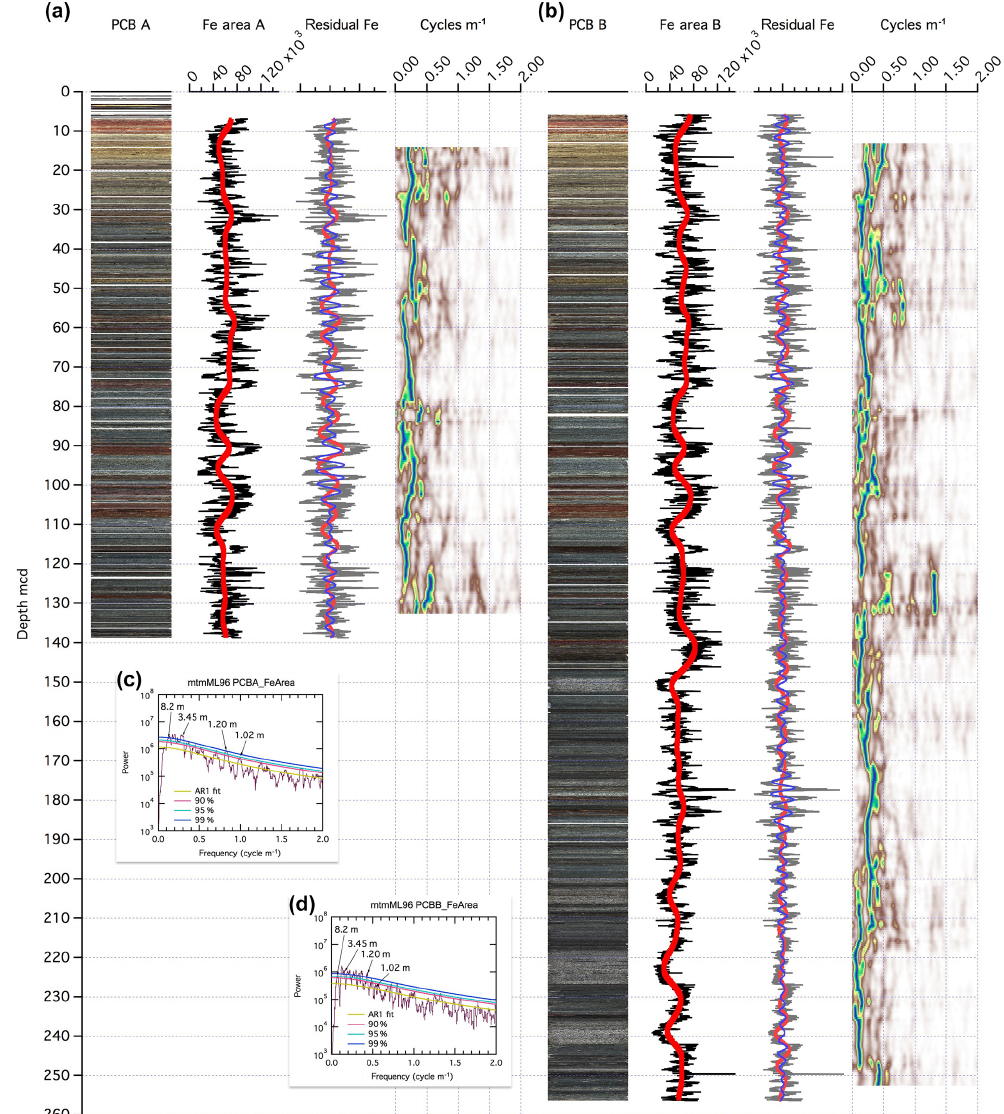
Figure 2. Polecat Bench PCB-A (a) and PCB-B (b) core images, XRF Fe intensity data, and spectral analysis on composite depth scale. Core scan images have been assembled with software package CODD (Wilkens et al., 2017). XRF Fe intensity (black line) with the trend (thick red line) removed for following spectral analysis. Residual Fe after trend removal and two Gaussian filters of the dominant cycles 8m (red) and 3.5m (blue). Evolutive spectral plot to decode changes in the cyclicity and thus sedimentation rates. Panels (c, d) show the MTM power spectra for PCB-A and PCB-B Fe